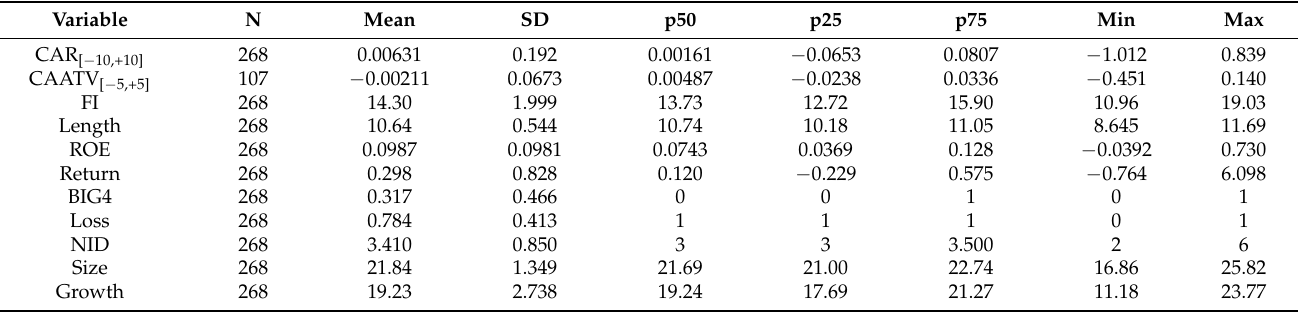
Table 1. Descriptive statistics of readability and CAR.